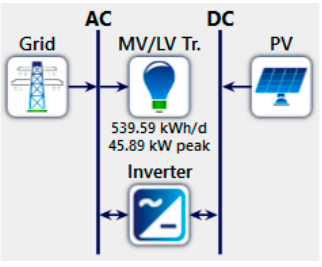
Figure 7. Schematic of the grid-connected PV system.